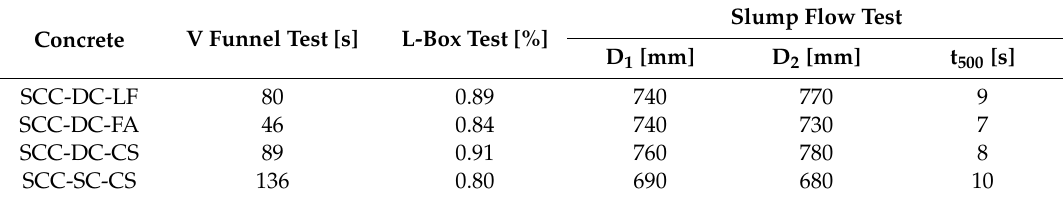
Table 6. Rheological properties of the self-compacting concrete in fresh state.